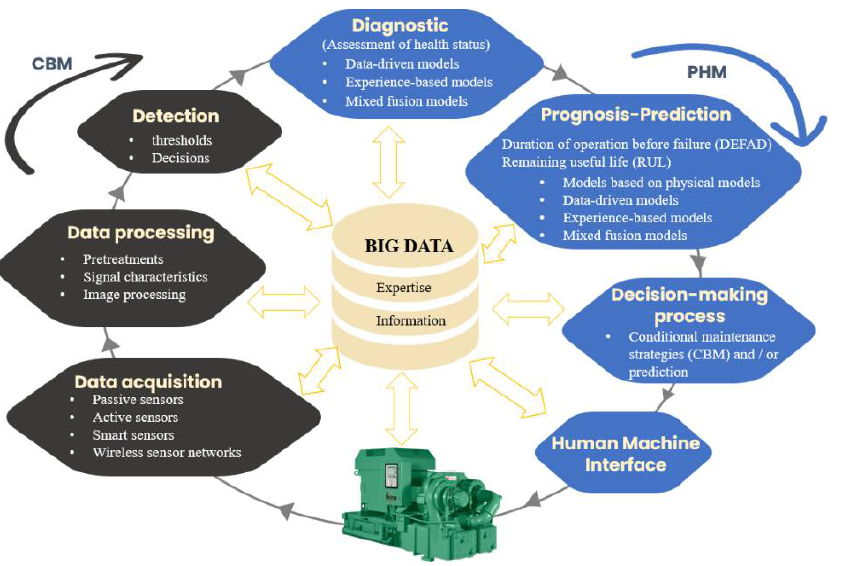
Figure 15. Components of the CBM/PHM approach for a compressor [80]